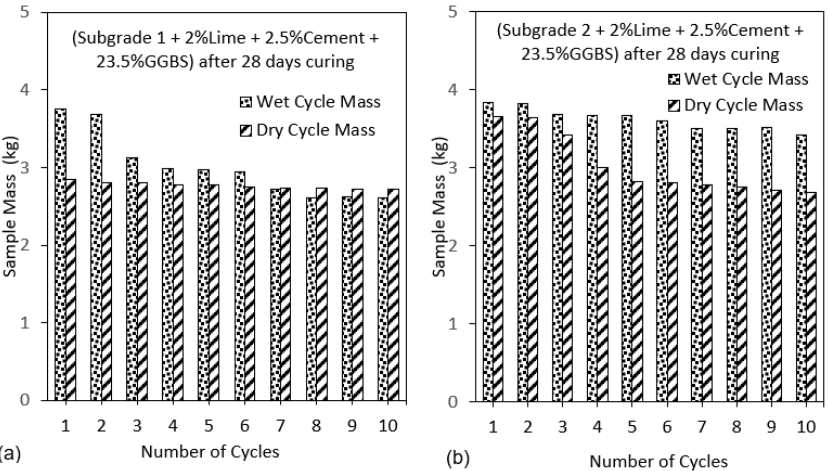
Figure 2. ( a ) Sample mass for subgrade 1 composed of GGBS after 28 days of curing ( b ) Sample mass for subgrade 2 composed of GGBS after 28 days of curing.